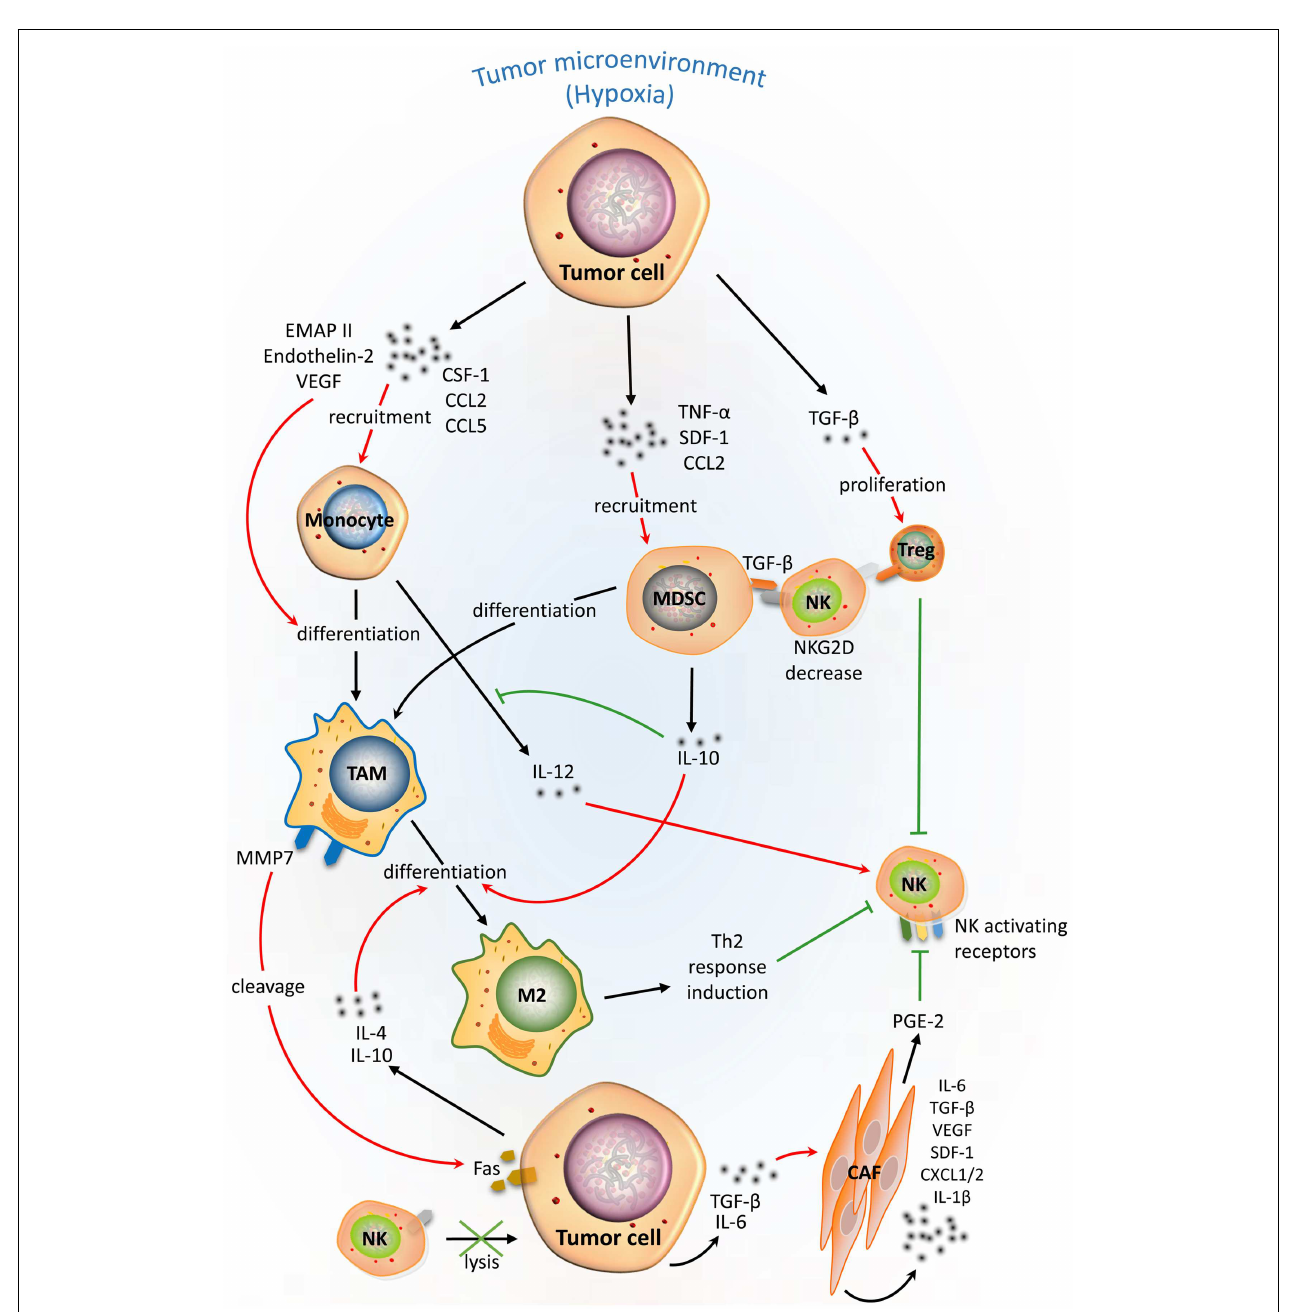
stromal cells such as cancer-associated fibroblasts (CAFs).This scheme summarizes the effects of tumor-derived soluble factors on recruitment, differentiation, proliferation, and activation of tumor-associated cells (red arrows) in the hypoxicTME and their immunosuppressive activities (green lines) on NK-mediated lysis of tumor